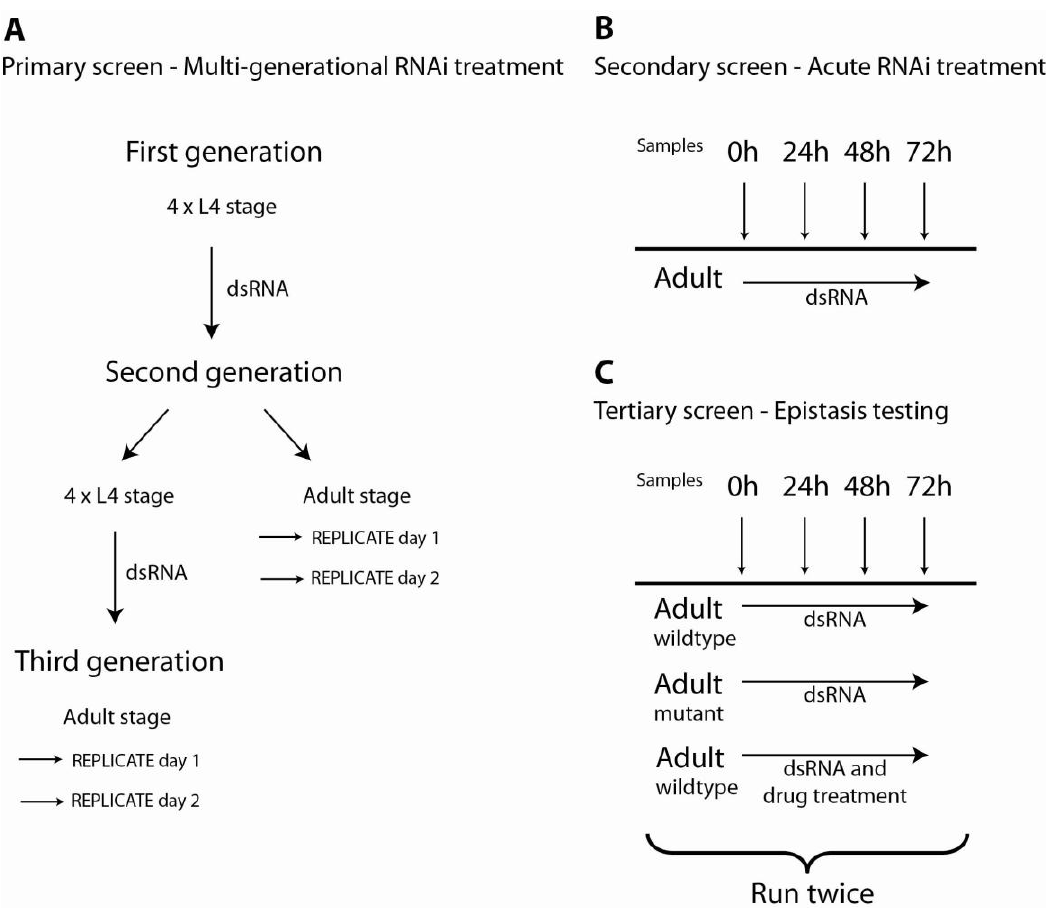
Figure 1. Schematic of the protocol for primary, secondary and tertiary RNAi screens. (A) Flowchart for the chronic, primary RNAi screen over three generations. Four L4 stage animals and their subsequent generation of progeny were fed RNAi throughout their development. Four L4 stage worms of the second generation were transferred to freshly prepared RNAi plates to screen a third generation fed RNAi throughout development. Replicate samples of 20 worms each were examined at day 1 and day 2 of the adult stage for both second and third generations. These animals were scored for developmental and behavioural defects and subcellular defects at each time point. (B) Flowchart for the acute, secondary RNAi screen in adult worms. Genes identified in the chronic screen (panel A) were re-examined in the secondary screen. L1 larvae were synchronized and then synchronized adult worms were fed RNAi. Samples were taken at 0, 24, 48 and 72 hours after onset of feeding and animals were examined for the same subcellular defects as identified in the primary screen. (C) Flowchart for the tertiary RNAi screen. Only genes identified in the acute screen (panel B) as potential regulators of protein degradation were re-examined in the tertiary screen. L1 larvae were synchronized and then synchronized adult worms were fed RNAi. For the tertiary screen, both wild-type and various mutant worms (typically unc-51 , daf-18 , and mpk-1 [30]) were used. Additionally, some wild-type worms were also treated with drugs at the onset of RNAi feeding (typically proteasome inhibitor MG132 [30]). The tertiary screen was run twice for each gene of interest and at least once more if results from the first two runs were not consistent with each